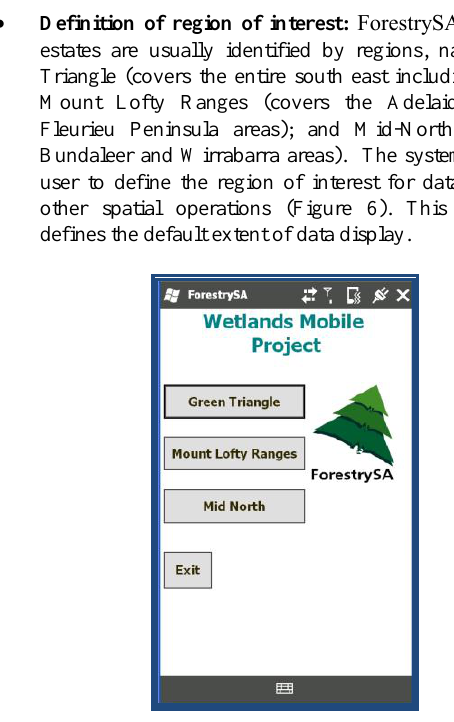
Figure 6. System interface for defining region of